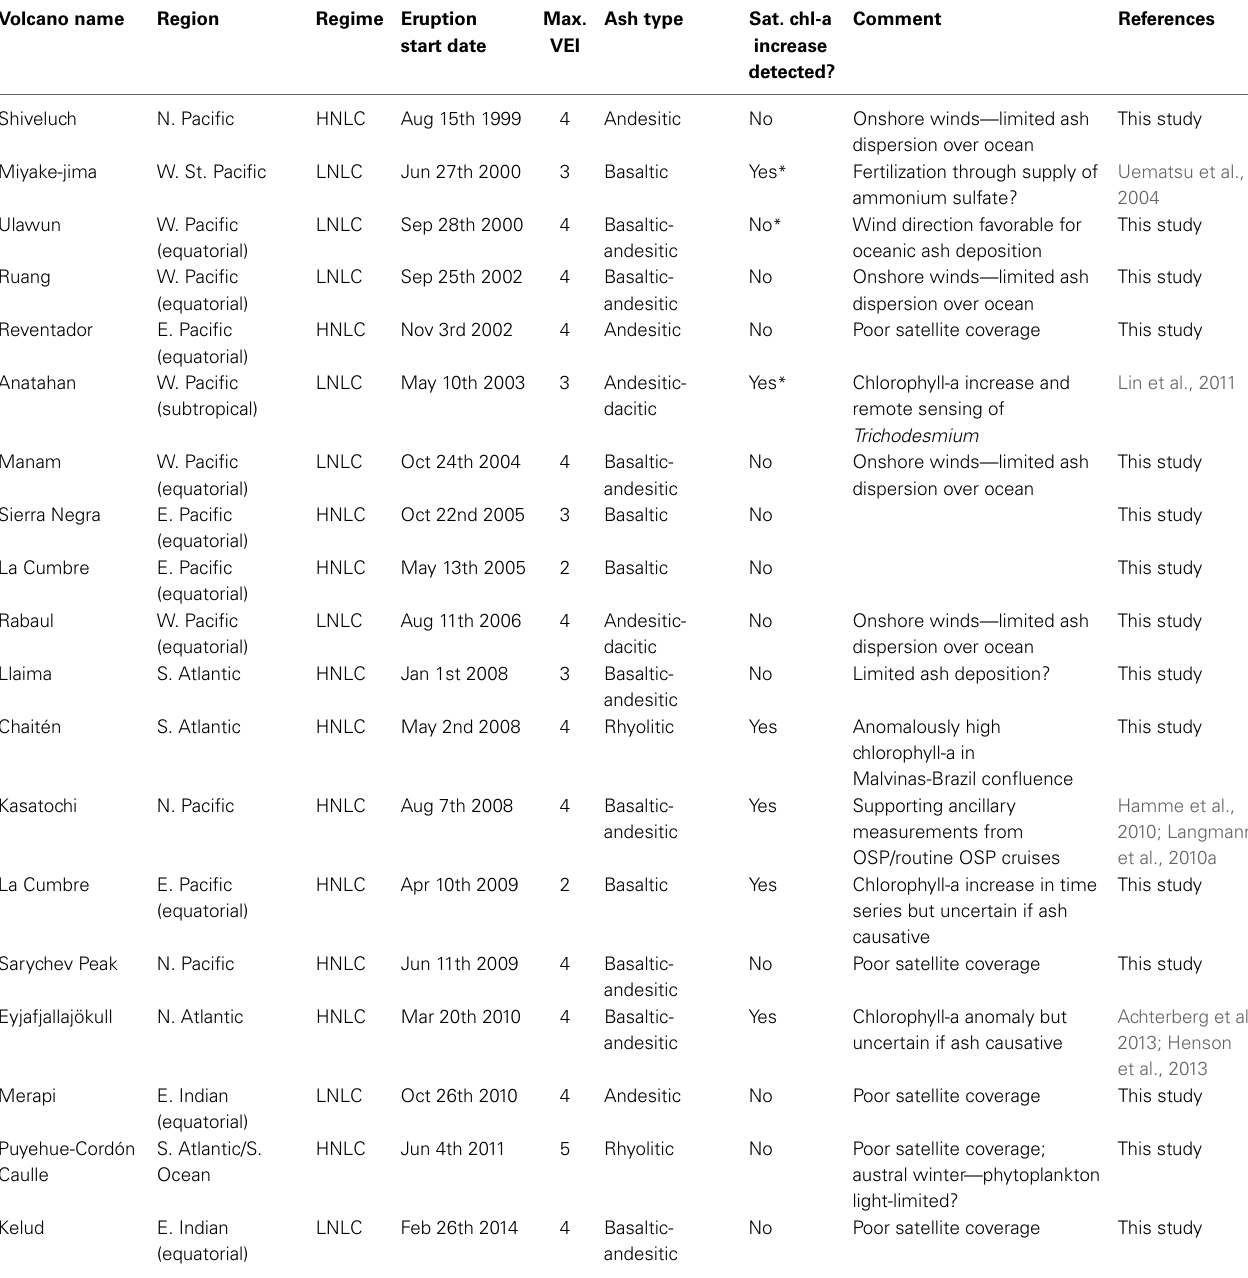
Table 3 | Summary of remote sensing case studies discussed in order of occurrence (1999–2014) a